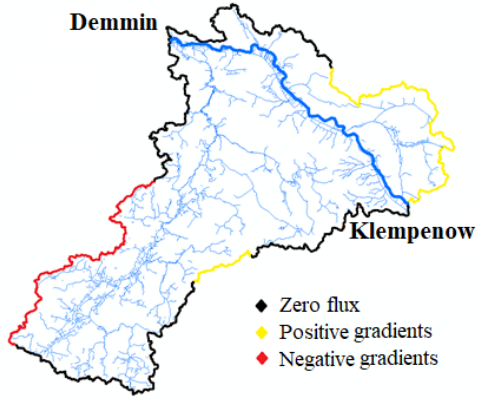
Figure 6. Boundary conditions used in the SZ, where the black line is zero flux BC, the yellow line is positive gradient BC, and the red line is negative gradient BC.